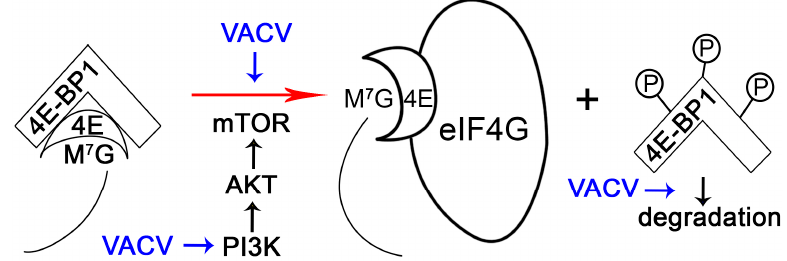
Figure 2. Vaccinia virus manipulates 4E-BP to favor viral protein synthesis. Mammalian 4E-BP is a translation repressor by sequestrating the cap-binding protein eIF4E. The M 7 G and the line represent the 7-Methylguanosine-cap structure and mRNA, respectively. This inhibition can be lifted through phosphorylation of 4E-BP via PI3K/AKT/mTOR axis. Vaccinia virus (VACV) infection activates PI3K (blue arrows represent the activation action), which then stimulates mTOR signaling. In turn, mTOR mediates phosphorylation of 4E-BP (shown as Ps attached to the 4E-BP1 protein), lifting the block on eIF4E (shown as 4E). In addition to enhancing phosphorylation of 4E-BP1, VACV also reduces the abundance of 4E-BP1 possibly by promoting the degradation of phosphorylated 4E ‐ BP1.